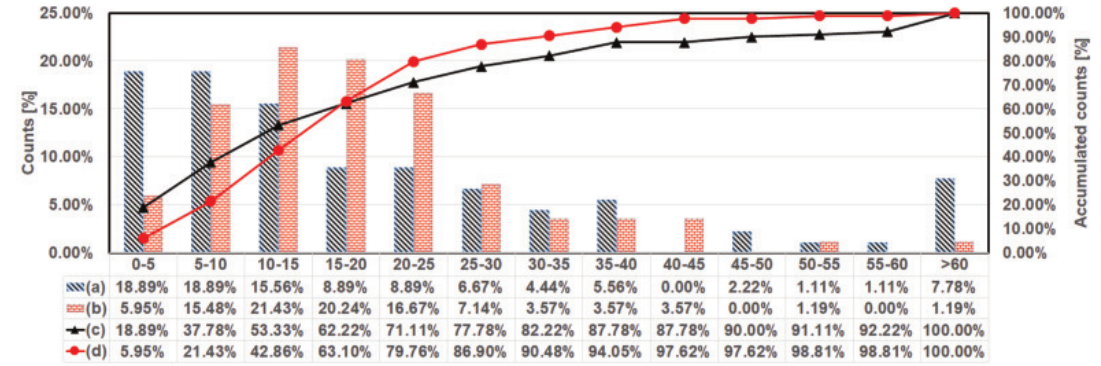
Figure 10. Histogram of visiting duration for all hens. ( a ) Without lay eggs; ( b ) With lay eggs; ( c ) Accumulated amount of hens without nest visits with lay eggs; ( d ) Accumulated amount of hens with nest visits with lay